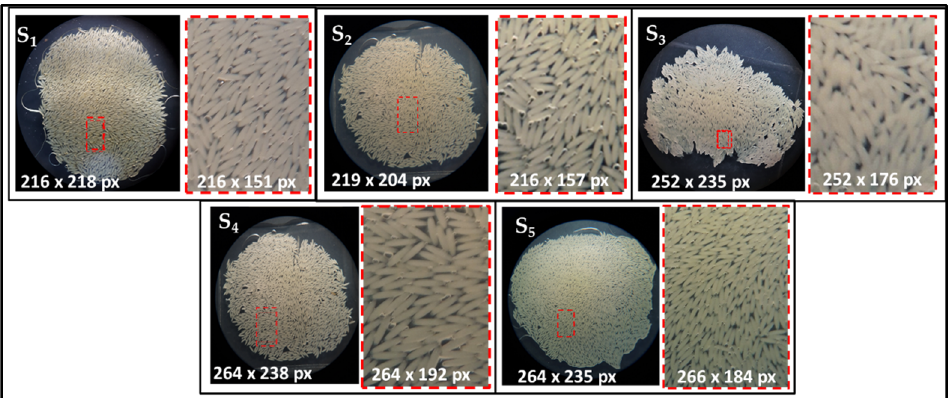
Figure 2. Quality of Hermetia illucens egg dispersion using different media: S 1 —glycerin 50%; S 2 — ethanol 70%; S 3 —ethanol 80%; S 4 —physiological serum 0.9%; S 4 —purified water. ethanol 70%; S 3 —ethanol 80%; S 4 —physiological serum 0.9%; S 5 —purified